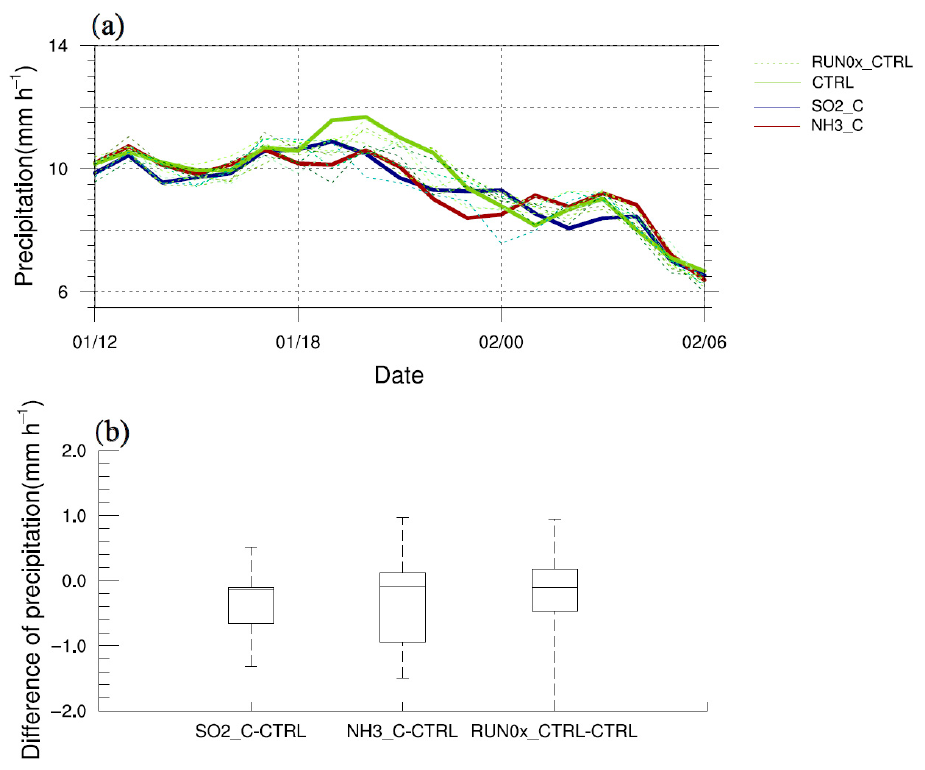
Figure 7. ( a )The time-series of area-averaged precipitation rate (mm h − 1 ) within the vortex. Only data exceeding 1.0 mm h are involved for analysis. ( b ) difference of precipitation between SO2_C and CTRL run, NH3_C, and CTRL run as well as RUN0x_CTRL and CTRL run in ( a ). Each box in ( b ) shows the minimum, the 25th percentiles, the median, the 75th percentiles, and the maximum value in the relevant datasets.